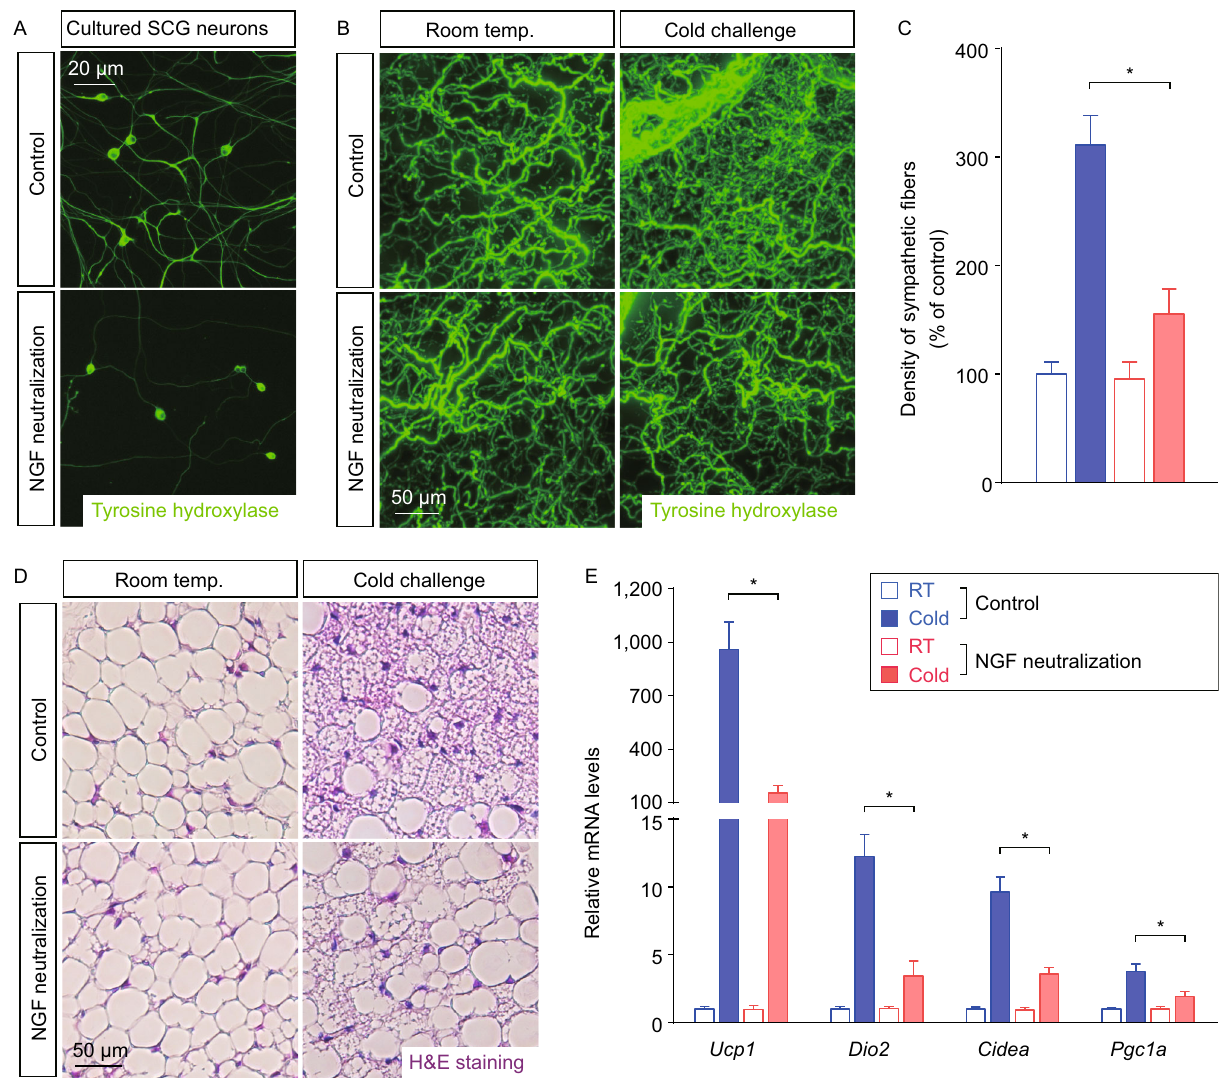
Figure 4. Intra-adipose sympathetic plasticity regulated by NGF is essential for cold-induced beiging process. (A) Repre- sentative images of cultured sympathetic SCG neurons treated with NGF-neutralizing antibody or control IgG. (B – E) The wildtype mice administrated with NGF-neutralizing antibody or control IgG were subject to cold challenge. (B) iWAT was processed for the volume fl uorescence-imaging of anti-tyrosine hydroxylase. Representative 3D projections of iWAT imaged at 12.6× magni fi cation on the lightsheet microscope. (C) Density of the sympathetic fi bers in iWAT was quanti fi ed. n = 5, mean ± SEM, * P < 0.01. (D) Appearance of multilocular beige cells in iWAT was examined by H & E staining. (E) Expression levels of the beiging-related genes in iWAT were determined by the qPCR analysis. n = 5, mean ± SEM, * P <